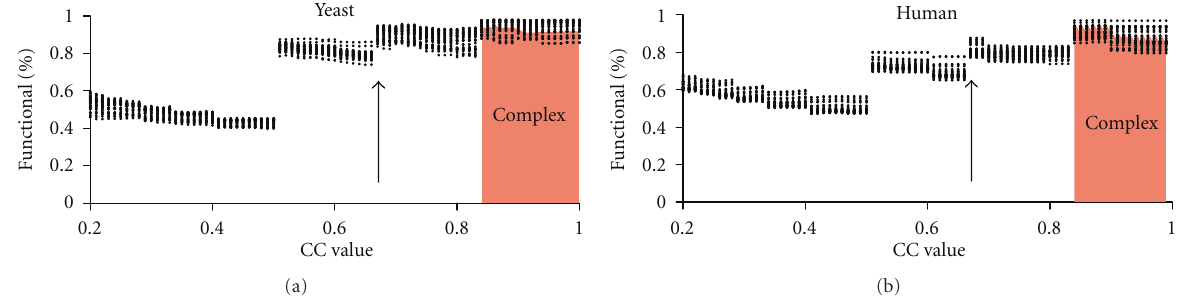
Figure 2: Performance of MOfinder in terms of various cut-o ff values for yeast and human network. Each point represents the functional percentage of modules observed for a cut-o ff value and a slide window. (a) Yeast PPI network. (b) Human PPI